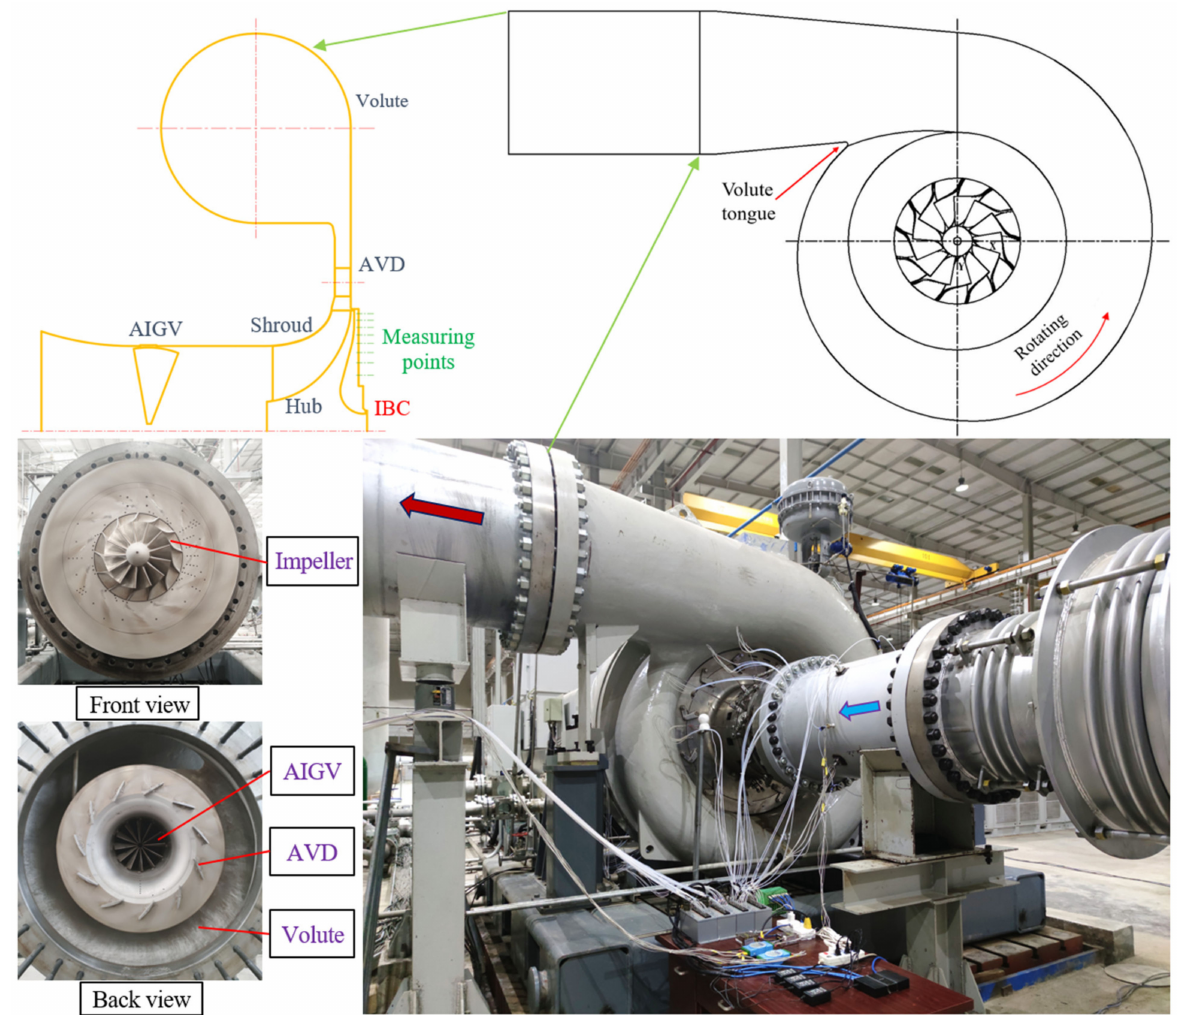
Figure 1. Geometric structure and site map of the research